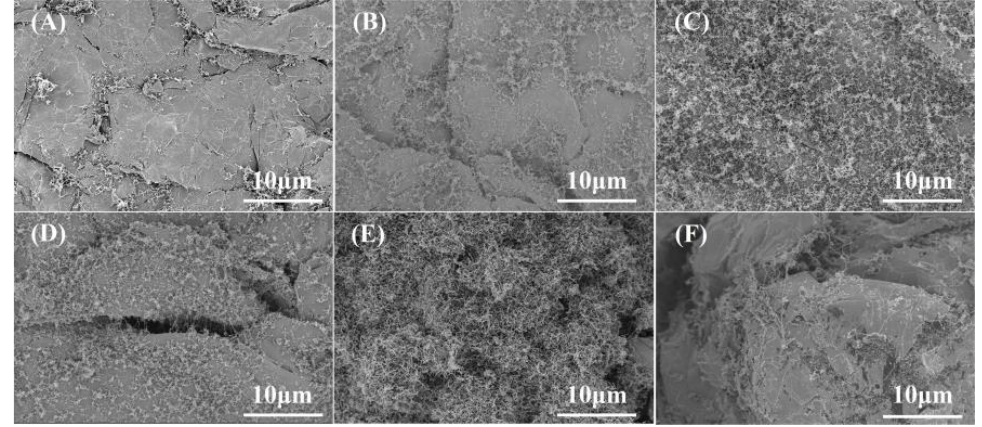
Figure 3. SEM images of MWCNTs prepared at different temperatures: ( A ) CNT 750 ; ( B ) CNT 780 ; ( C ) CNT 810 ; ( D ) CNT 840 ; ( E ) CNT 870 ; ( F ) CNT 900 .